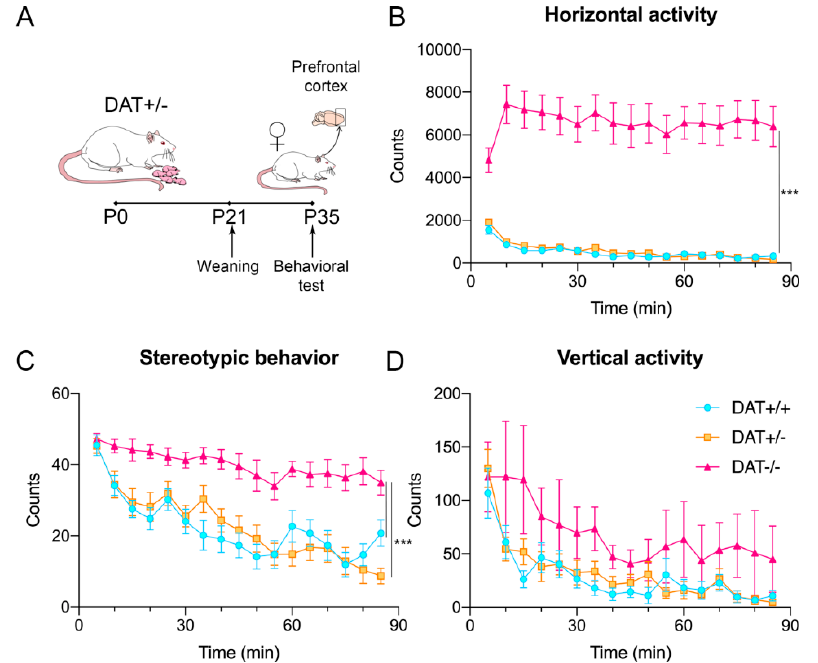
Figure 1. Behavioral deficits of female adolescent DAT − / − rats. ( A ) Schematic illustration of the experimental timeline. Rats were culled by DAT+/ − mothers and weaned at PND21; at PND35, female rats were tested for locomotor activity. Brain tissue was isolated immediately after behavioral test. Behavioral activity in the open field: ( B ) horizontal activity, ( C ) stereotypic behavior counts and ( D ) vertical activity ( D ). Data are presented as mean ± SEM; *** p < 0.001.